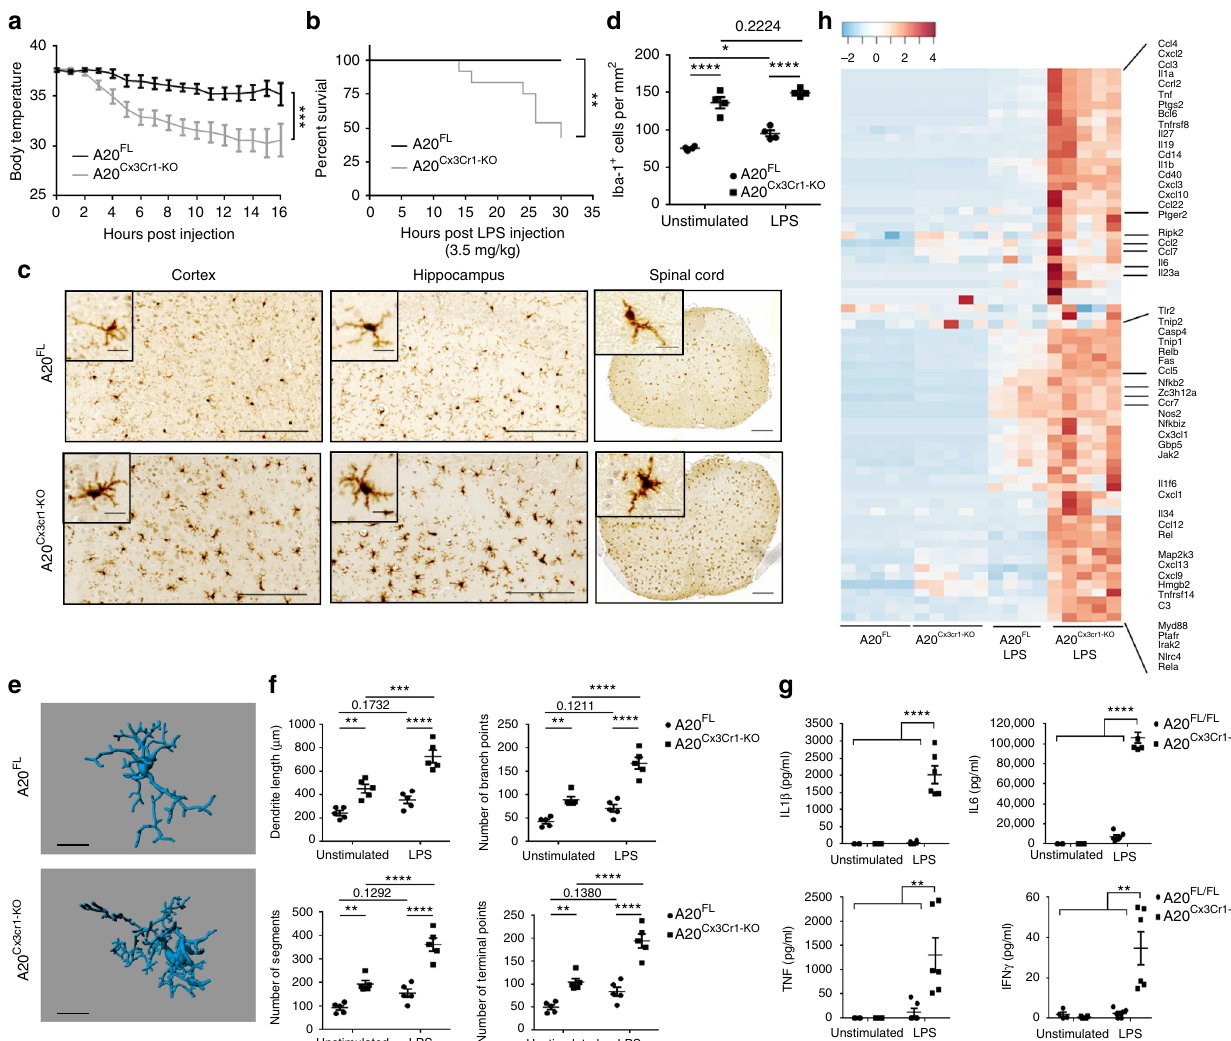
Fig. 3 A20 Cx3Cr1-KO mice are hypersensitive to LPS. a Rectal body temperature responses and b survival were analyzed in function of time in control (A20 FL ; n = 13) and A20 Cx3Cr1-KO ( n = 14) mice after intraperitoneal injection of 3.5 mg/kg LPS. The combined results of three independent experiments are shown. Body temperature data are means ± SEM. Statistical differences were determined by a REML analysis for rectal body temperatures and a Mantel – Cox test for the survival curve (** p < 0.01, *** p < 0.001). c Immunohistochemistry images showing Iba-1 + expression in the cerebral cortex, hippocampus and spinal cord of control (A20 FL ) and A20 Cx3Cr1-KO mice 10 h post LPS challenge. Scale bars represent 100 µ m (cortex and hippocampus) and 200 µ m (spinal cord), insert: 10 and 20 µ m, respectively. Representative images are displayed. Data are representative of two independent experiments. d Number of Iba-1 + rami fi ed parenchymal microglia in brain. Each symbol represents data from one mouse, n = 4 per group. Data are presented as mean ± SEM. Signi fi cant differences were determined by a two-way ANOVA with Tukey correction for multiple comparison (* p < 0.05, **** p < 0.0001). e , f Three-dimensional reconstruction (scale bars represent 10 µ m, e ) and Imaris-based semiautomatic quanti fi cation of cell morphology ( f ) of cortical Iba-1 + microglia. Each symbol represents the average of three measured cells per mouse; n = 5 per group. Data are presented as mean ± SEM. Signi fi cant differences were determined by two-way ANOVA with Tukey correction for multiple comparison (** p < 0.01, *** p < 0.001, **** p < 0.0001). g Bioplex analysis of cytokine levels in CSF 10 h post LPS. Each symbol represents one mouse. Data are representative of three independent experiments. Signi fi cant differences were determined by a one-way ANOVA with Tukey correction for multiple comparison (** p < 0.01, **** p < 0.0001). h RNA prepared from FACS-sorted microglia from control (A20 FL ) and A20 Cx3Cr1 mice either or not injected with LPS for 10 h was submitted for RNA sequencing. Heat map of expression values for in fl ammatory genes that are upregulated in LPS-stimulated A20 Cx3Cr1 microglia compared with LPS-stimulated control microglia. Each column represents microglia data from one individual mouse, with four or fi ve mice per group. Color code presents linear